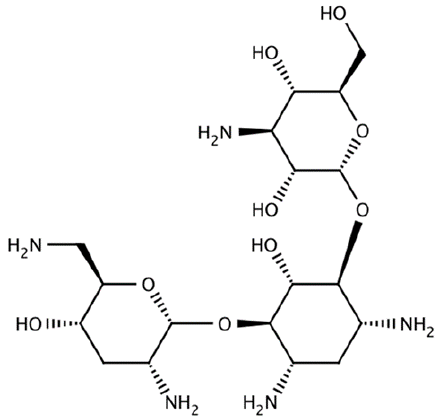
Figure 1. Tobramycin molecular structure.